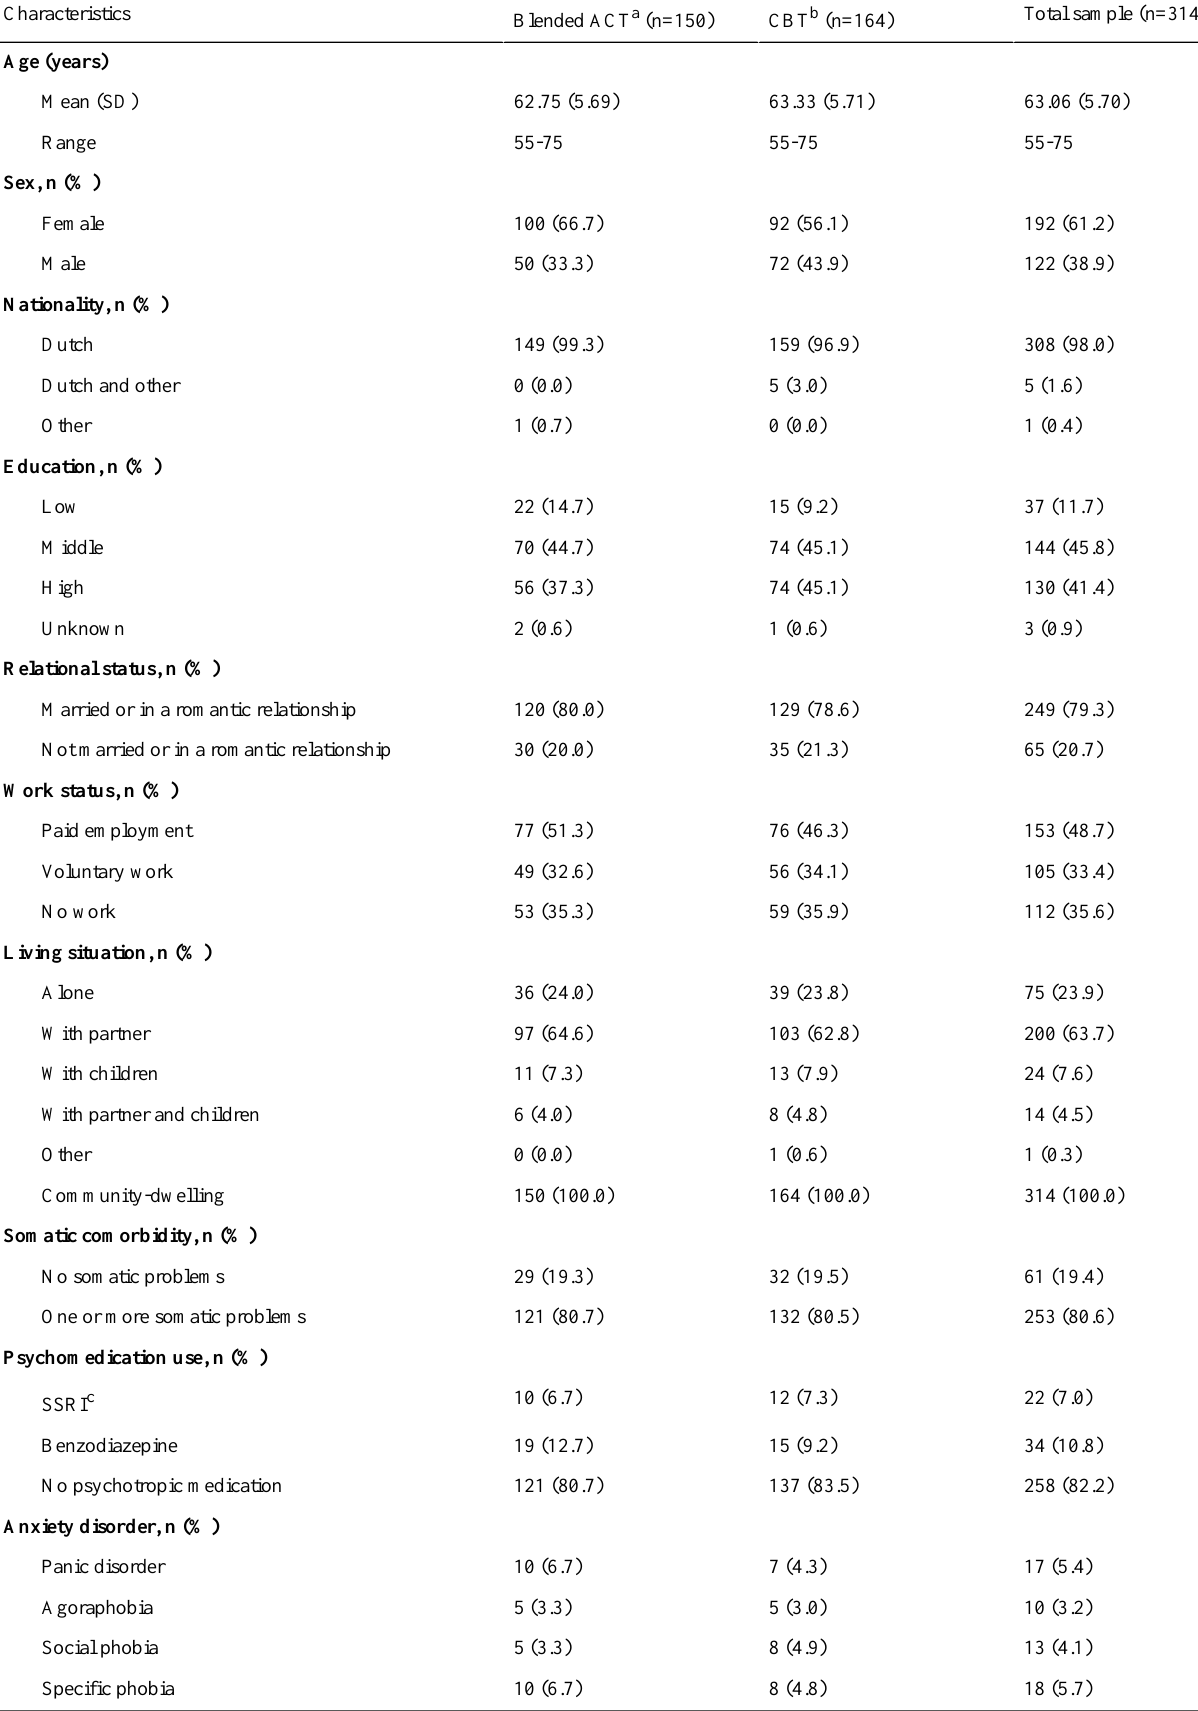
Table 2. Baseline characteristics of study